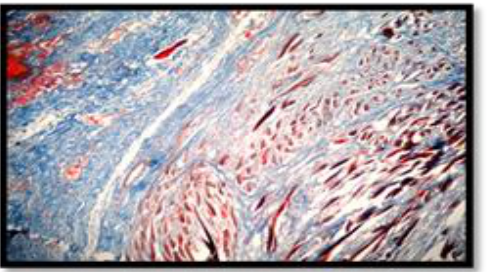
Figure, 11: BP-treatment group at 16th week post implantation shows moderate vascular granulation tissue with moderate cellular infiltration was identified (Mallory stain, 100X).